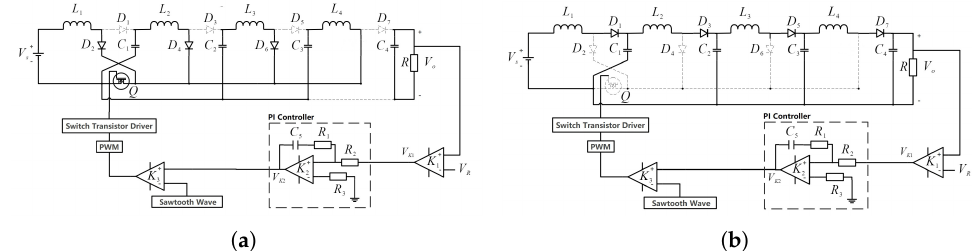
Figure 9. Stage of the single-switch four-stage Z-network high-gain boost converter: ( a ) stage I; ( b ) stage II.